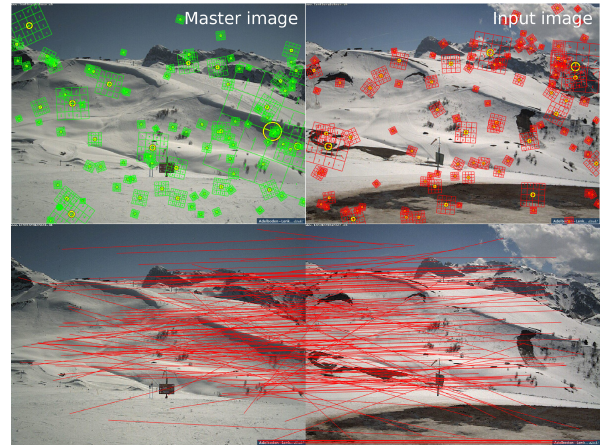
Figure 8. SIFT features of a master image and an input image and corresponding matches between all features. To simplify the illus- tration, we show a subset of 100 randomly selected SIFT features per image. Webcam images: Hahnenmoos, © Skiregion Adelboden- Lenk.